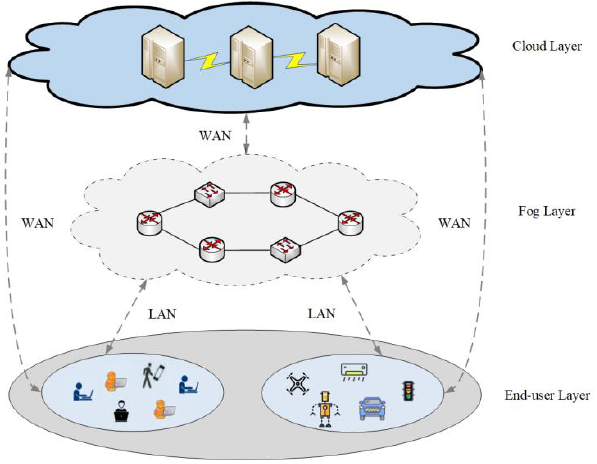
Figure 2. Fog infrastructure